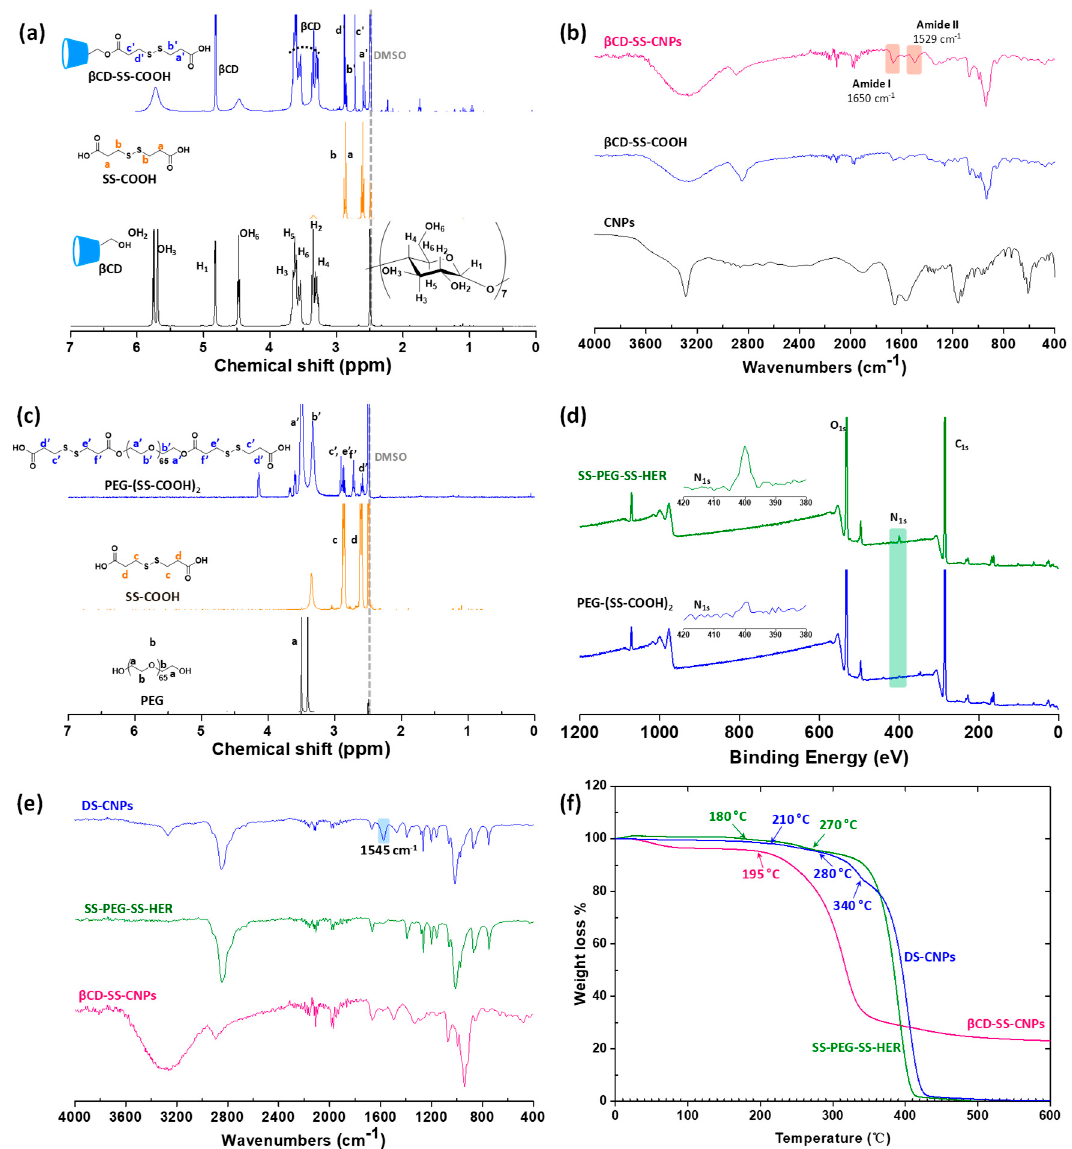
Figure 1. ( a ) Synthesis of β CD-SS-COOH confirmed by 1 H-NMR, ( b ) synthesis of β CD-SS-CNPs confirmed by FTIR, ( c ) synthesis of PEG-(SS-COOH) 2 confirmed by 1 H-NMR, ( d ) synthesis of SS-PEG-SS-HER confirmed by XPS, synthesis of DS-CNPs confirmed by FTIR ( e ) and TGA ( f ).